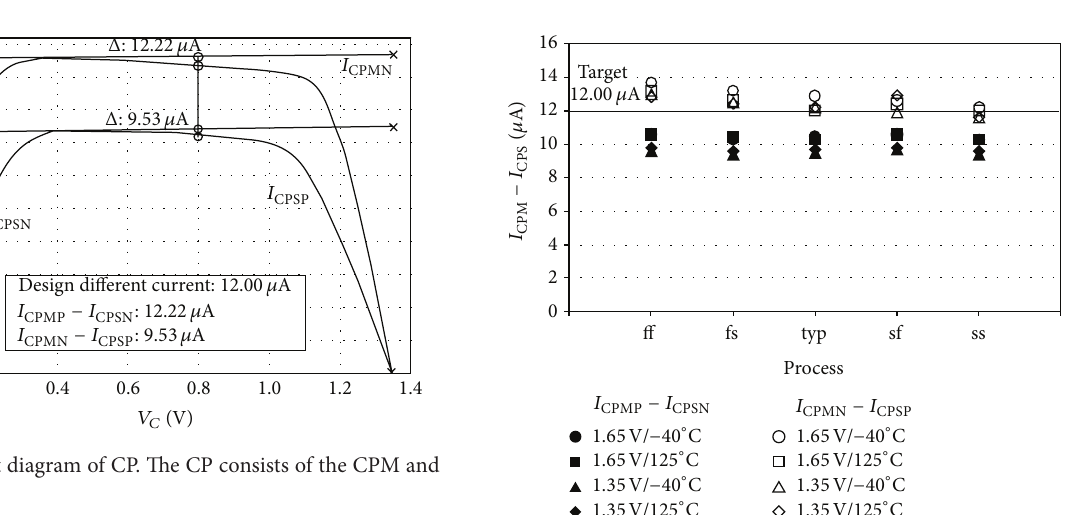
Figure 12: Simulation result of different CP current ( 𝐼 − 𝐼 𝐼 ). Design target current is that 𝐼 CPMN CPSP ( 𝐼 and 𝐼 ) are 44mA and 32 mA, and 𝐼 CPS CPSP CPSN